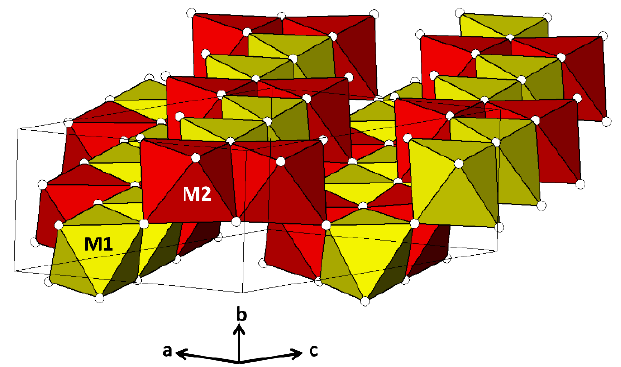
Figure 1. Polyhedral structure of pseudorutile and kleberite viewed along [101]. M1 = Ti, M2 = Fe for pseudorutile and M1 = Ti, M2 = Ti for kleberite.